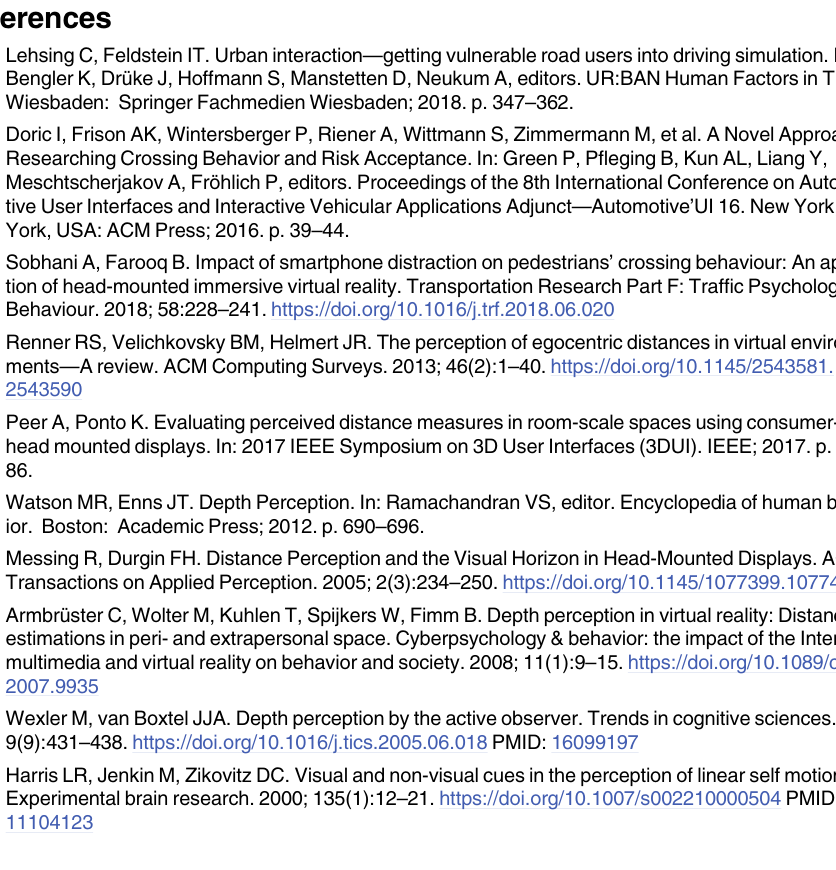
S6 Fig. Effect of distance (scaled by translation gain) on visually guided walking.